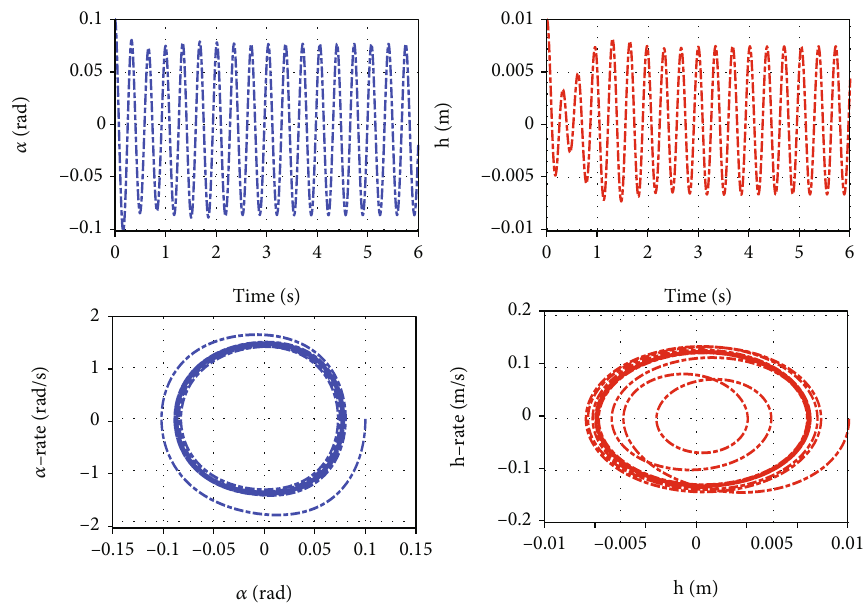
Figure 6: The open-loop responses of the aeroelastic system.